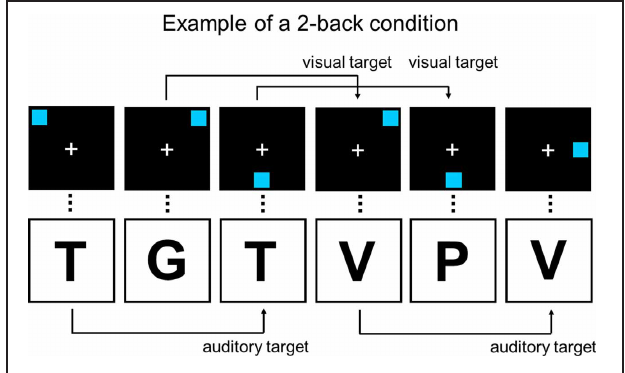
FIGURE 1 | Example of a 2-back condition in the dual n -back task that was used as the training task. The visual and auditory stimuli are presented simultaneously at identical rates. Figure adapted from Buschkuehl and colleagues